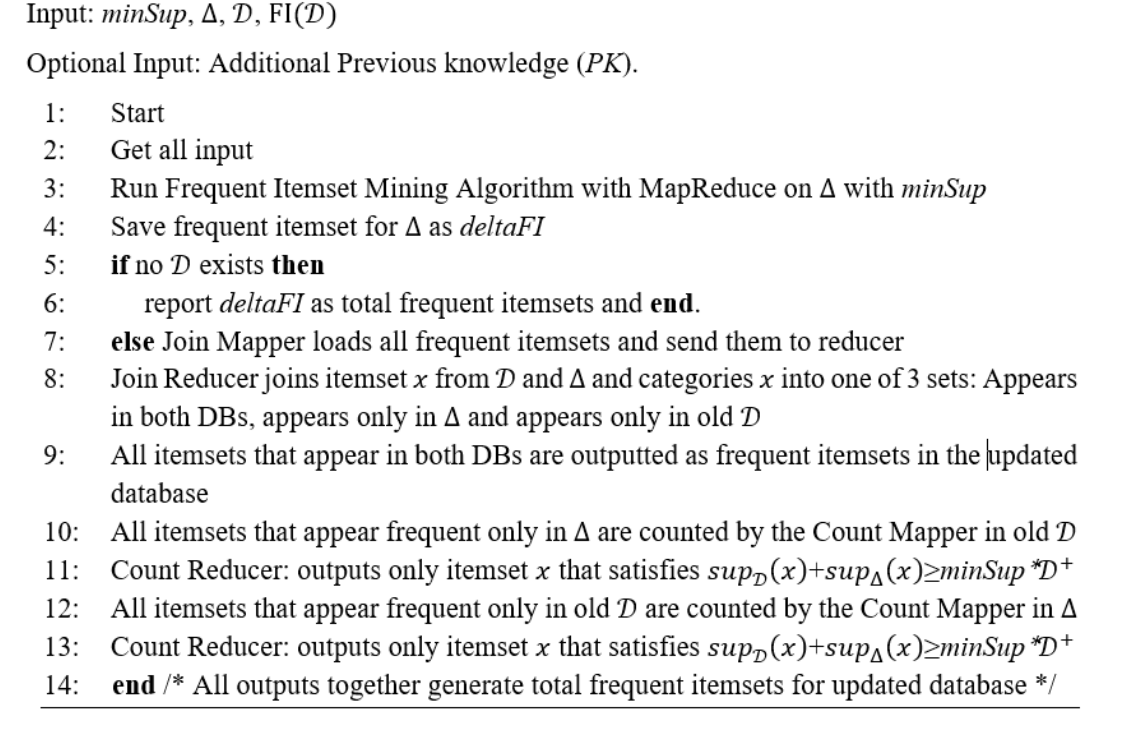
Algorithm 5. General incremental frequent itemset mining